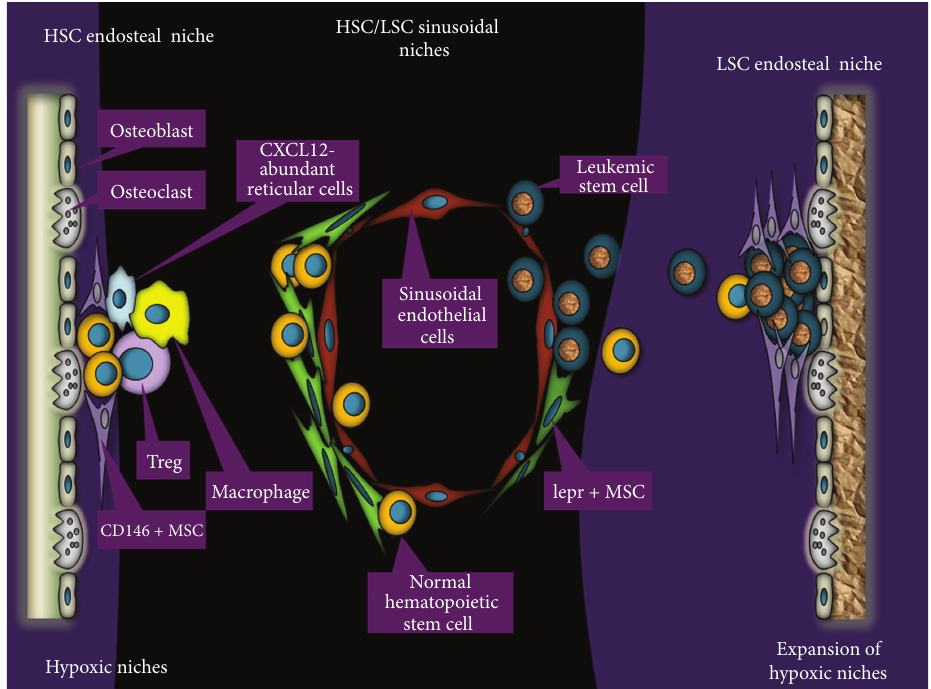
F 1: Organization of normal hematopoietic stem cell (HSC) and leukemic stem cell (LSC) niches in the bone marrow. Both HSCs and LSCs establish niches around the bone marrow endosteum and sinusoids. In normal hematopoiesis, the endosteal niche is formed and regulatedbyosteoblasts,osteoclasts,mesenchymalstromalcells(MSCs),T-regulatorycells(Tregs),andmacrophages,whileinleukemia,LSCs associate with osteoblasts and mesenchymal stromal cells. HSCs form sinusoidal niches with sinusoidal endothelial cells and leptin receptor- (lepr+-) expressing-perivascular stromal cells. LSCs form sinusoidal niches with sinusoidal endothelial cells. Oxygen gradient decreases from the sinusoids to the endosteum. e normal HSC endosteal niches are hypoxic, while there is an expansion of hypoxic niches in LSC endosteal niches due to LSC